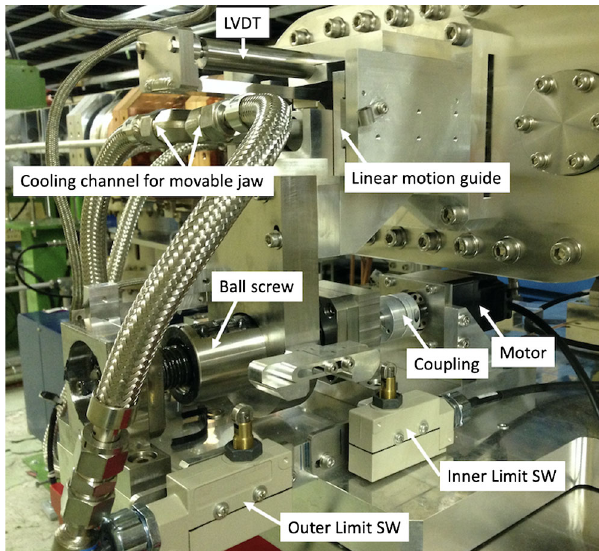
FIG. 12. Photograph of drive mechanism in the SuperKEKB- type